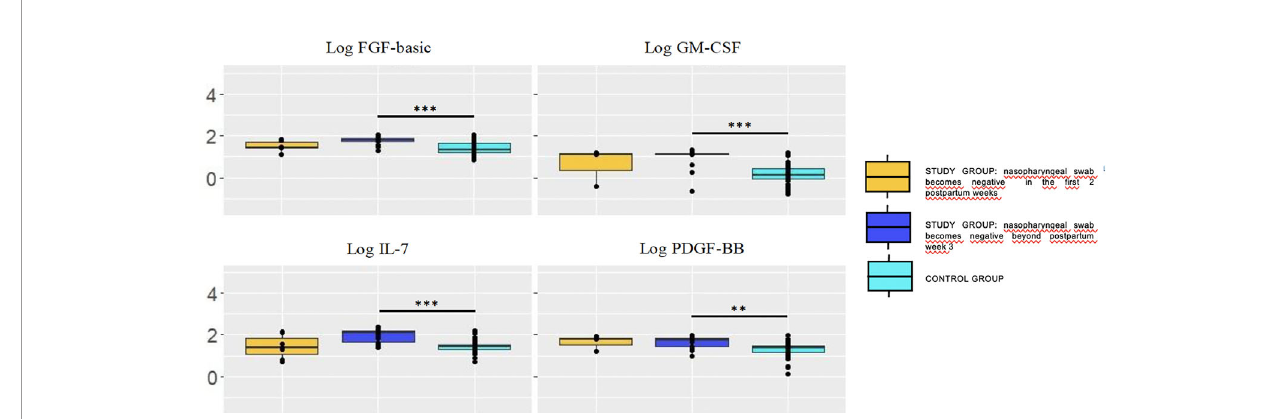
FIGURE 4 | Concentration (log) of growth factors in breastmilk of study group women according to the moment in which the nasopharyngeal test becomes negative (pooling samples obtained at week 1 and 5). Growth factors concentrations were signi fi cantly higher in breastmilk samples of mothers whose RT-PCR remained positive at postpartum week 3 (dark blue box) compared with the control group. Trends also pointed toward higher concentrations in the former compared with those who became negative sooner, within the fi rst two postpartum weeks (yellow box). The values are expressed as log 10 of the concentrations (ng/L). Statistical differences on pairwise post hoc comparisons between the study and control groups are indicated with an asterisk (*p < 0.05; **p ≤ 0.01; ***p ≤ 0.001, Wilcoxon rank test, Bonferroni post hoc test).